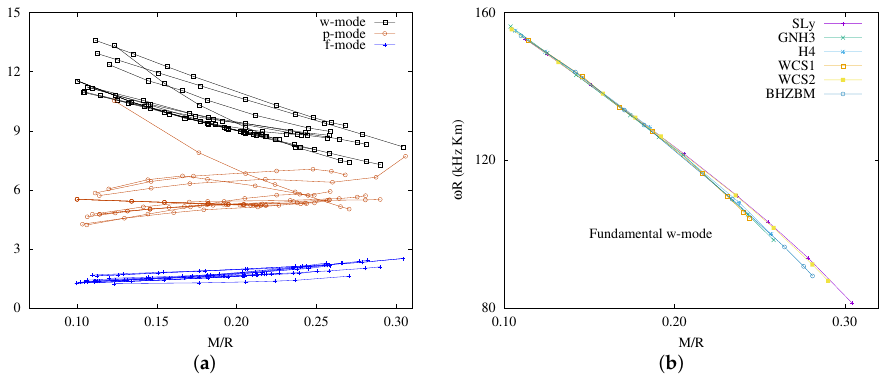
Figure 2. l = 2 polar QNMs: ( a ) frequency (in kHz) vs. compactness M / R for the fundamental f-mode, the pressure p-mode, and the space-time w-mode for several equations of state; ( b ) universal relation for the scaled frequency ω R vs. the compactness M / R for the w-mode